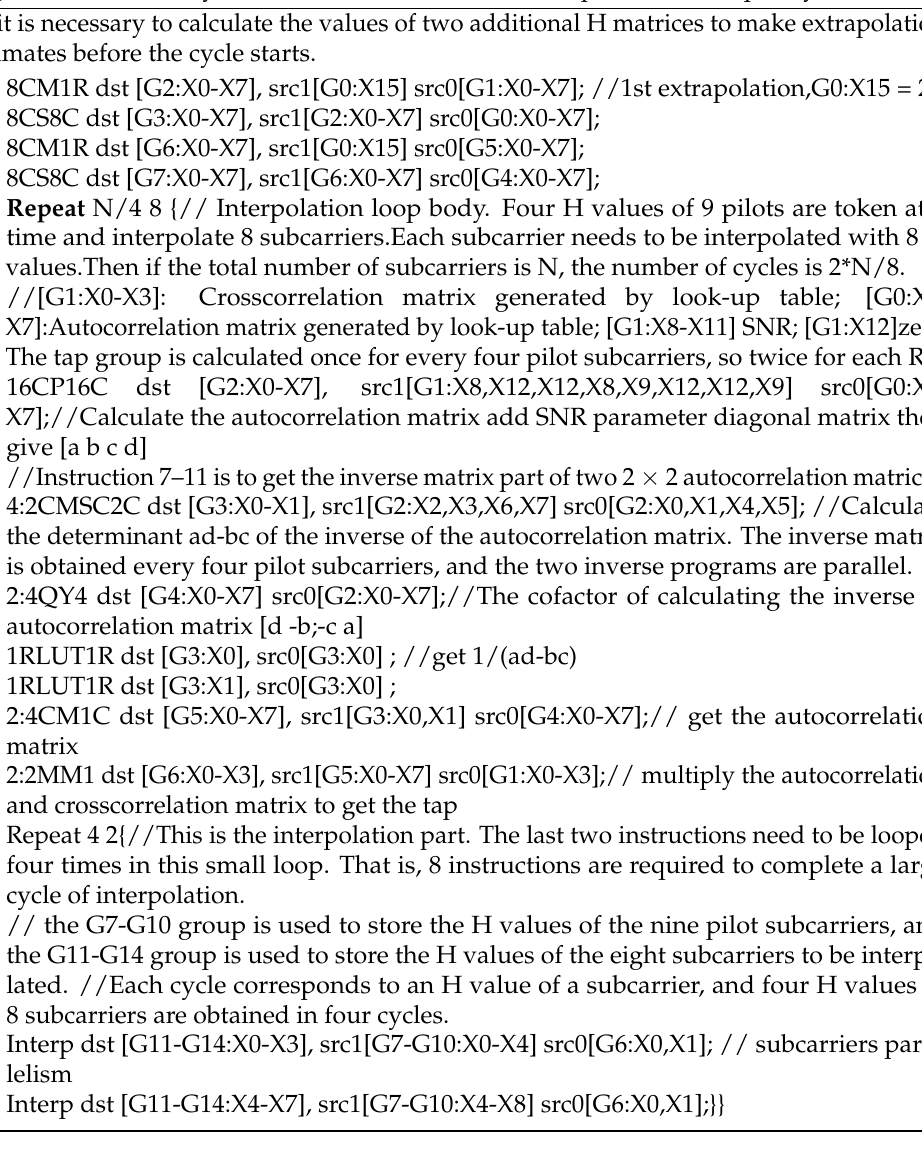
Algorithm 4 Assembly instruction code for Wiener interpolation in frequency